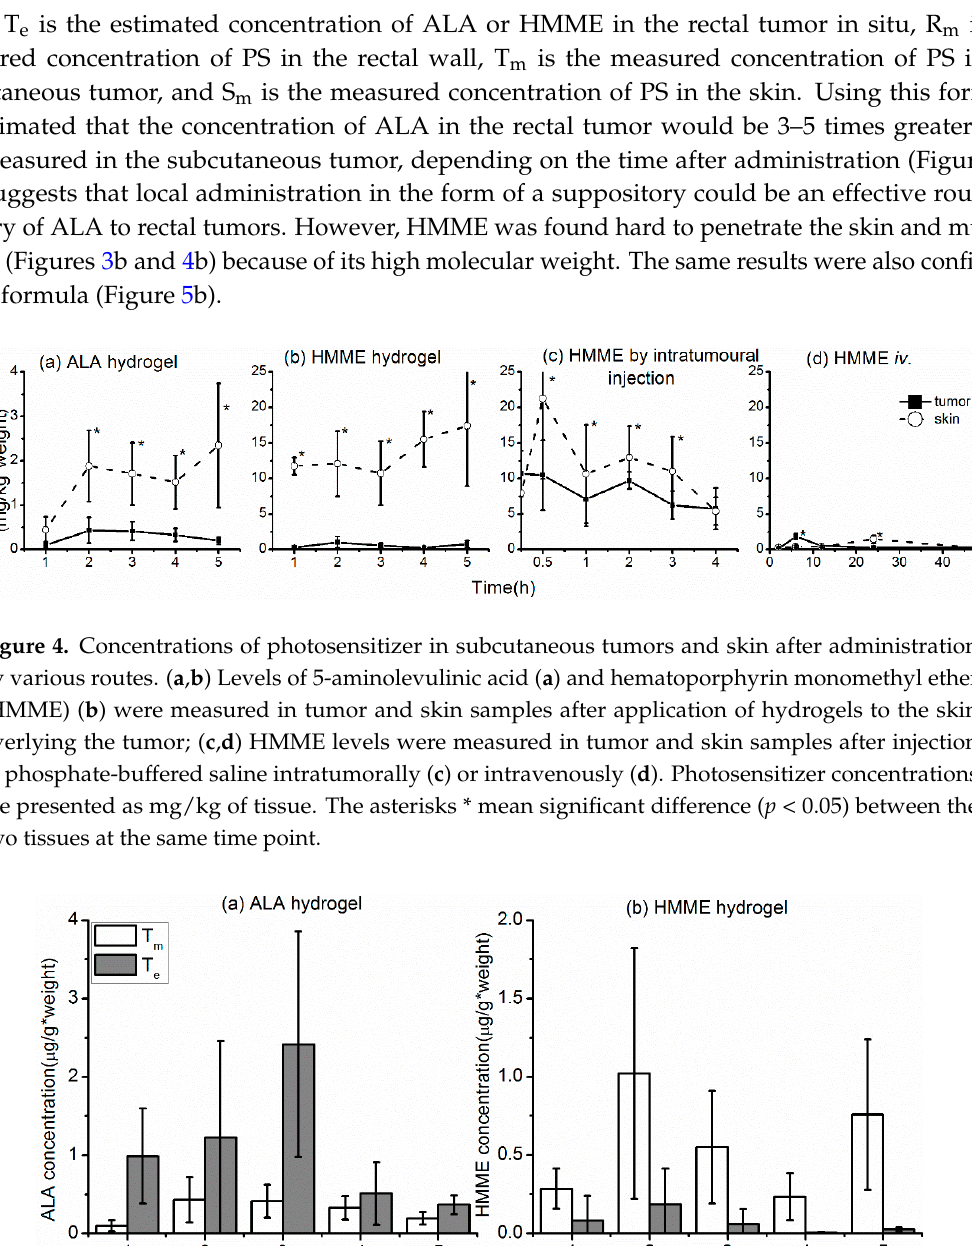
Figure 5. Estimated concentrations of 5-aminolevulinic acid (ALA) ( a ) and hematoporphyrin monomethyl ether (HMME) ( b ) in rectal tumors based on modeling of subcutaneous tumors. T m is the measured concentration of ALA in the subcutaneous tumors and T e is the estimated concentration of ALA in a rectal tumor.